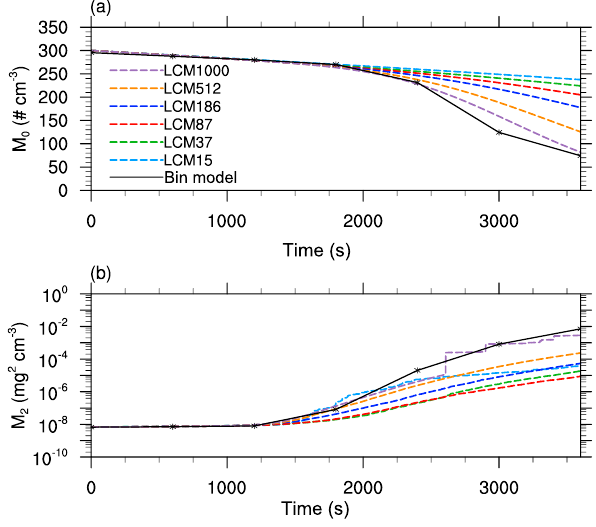
Figure 1. Mass density distribution for the single-box approach af- ter 3600s for the “singleSIP” initialization. The black solid line de- notes the solution of Wang et al. (2007). The colored dashed curves show the solution of the LCM with different numbers of super- droplets per grid box.